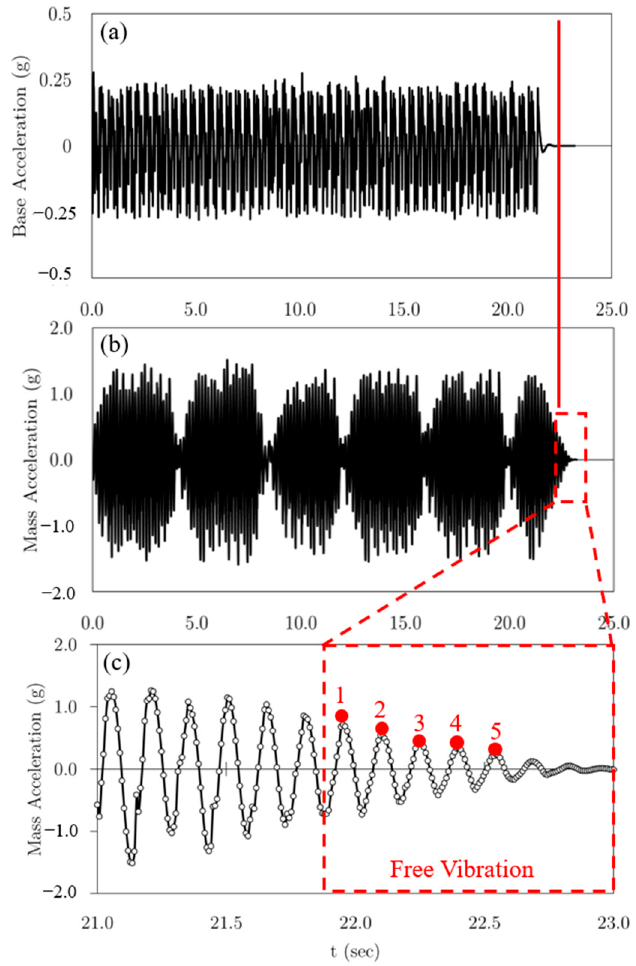
Figure 13. Time history responses of the SDOF system recorded during the lab testing; ( a ) base acceleration f b = 2.3 Hz, ( b ) tip mass acceleration (proper), and ( c ) tip mass acceleration under a free vibration.